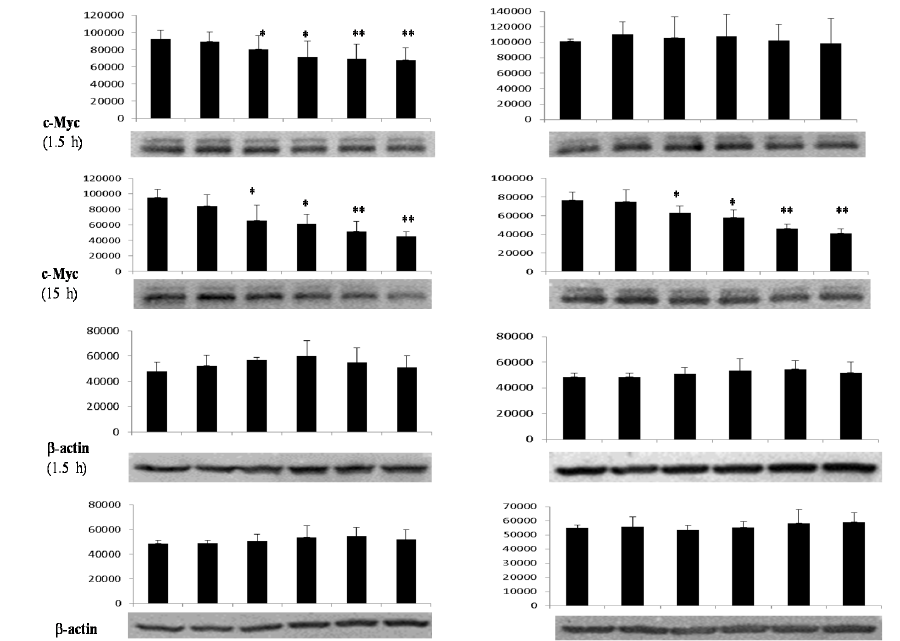
Figure 4. Effect of butyrate on the cell ‐ proliferation proteins. Western blot analyses of the effects of sodium butyrate (NaB) treatment for 1.5 h or 15h on intracellular signaling proteins (densitometric units) in ( A ) HCT116 colon cells and ( B ) NCM460 colon cells. Values are means ± SD, n = 4, * Different from control (0 mmol/L NaB); * p < 0.05, ** p < 0.0001. A representative Western blotting image was